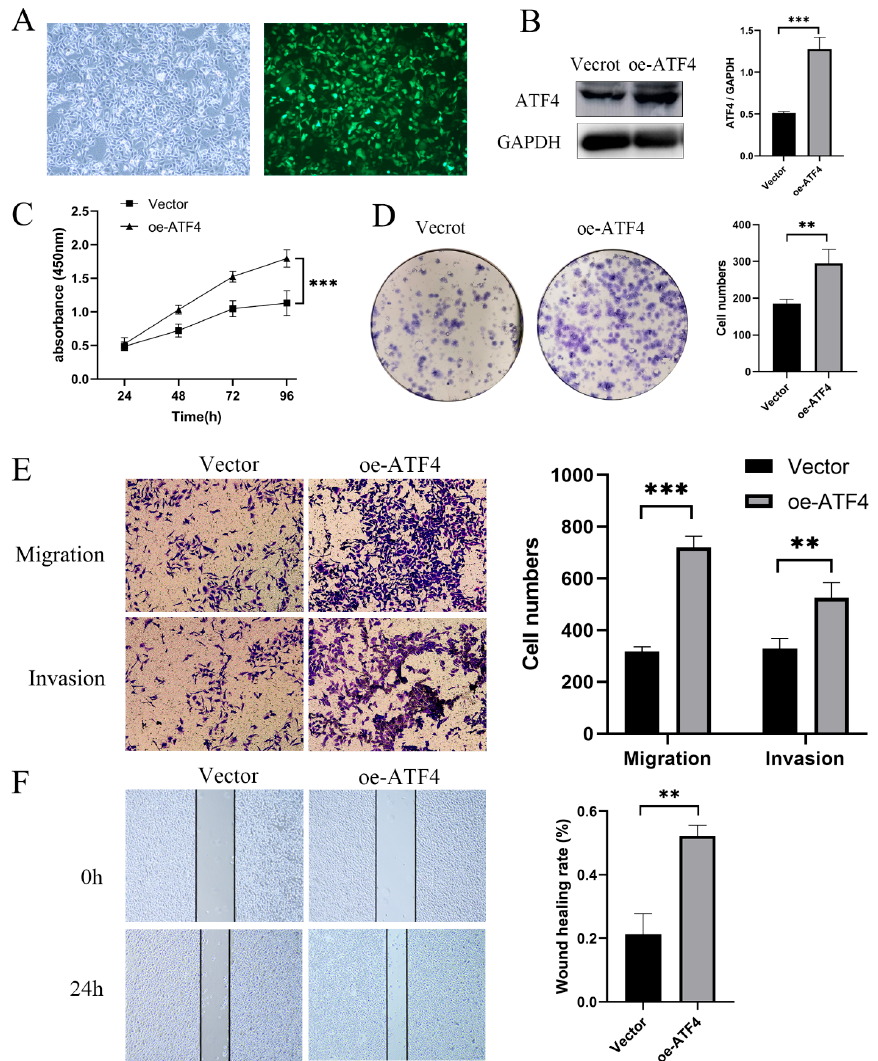
Figure 3. ATF4 upregulation promotes the proliferation and invasion of GC cells. ( A ) The lentiviral vector contains the green fluorescent protein sequence, and successfully transfected cells will express the green fluorescent protein. ( B ) Compared with cells transfected with empty vector, the expression of ATF4 in cells transfected with upregulation of ATF4 was significantly increased. ( C , D ) CCK8 and colony formation assay were used to assess whether ATF4 affects the proliferation of AGS cell. The results showed that compared with the control group, the proliferation rate of cells after up-regulating ATF4 was significantly increased. ( E , F ) The results of transwell and wound-healing experiments showed that the migration was significantly increased in the oe-ATF4 group compared with the Vector group in the AGS cell, ( E ) light microscopy (×20), ( F ) light microscopy (×10). ** p < 0.01, *** p < 0.001. The original western blot figures could be found in Supplementary S2.